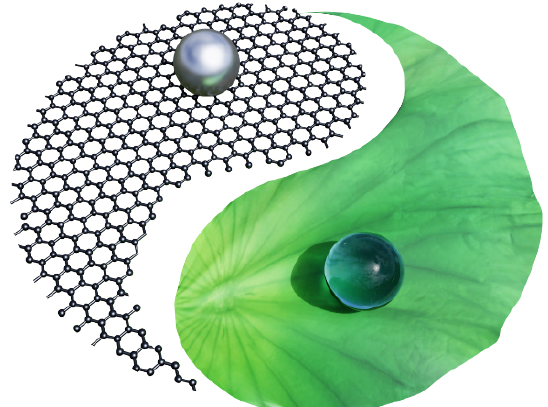
Fig. 1 Schematic illustration of superlubricity surface (left: friction pairs slide freely on the surface of graphene) and superslippery surface (right: liquid droplets move quickly alongside the surface of lotus